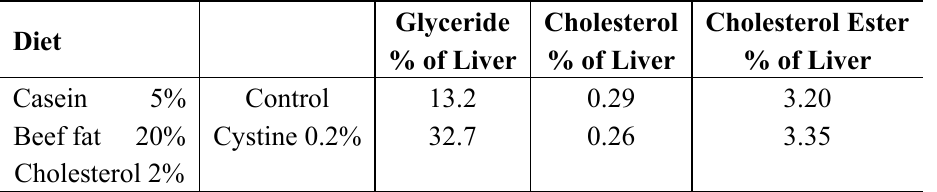
Table 5. Effect of Cystine (from [7]).